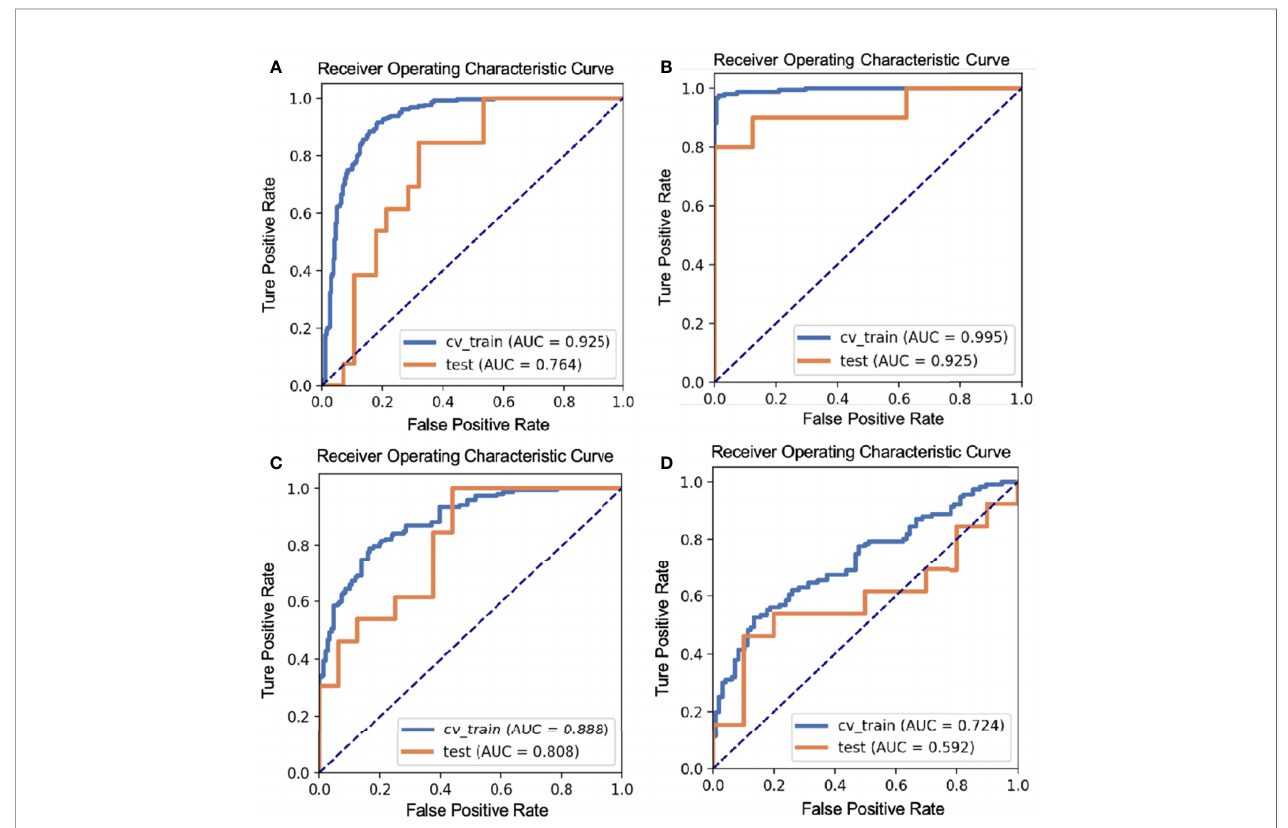
FIGURE 2 | The ROC curves of different parotid gland tumors: (A) BT vs. MT; (B) PA vs. WT; (C) PA vs. MT; (D) WT vs. MT.